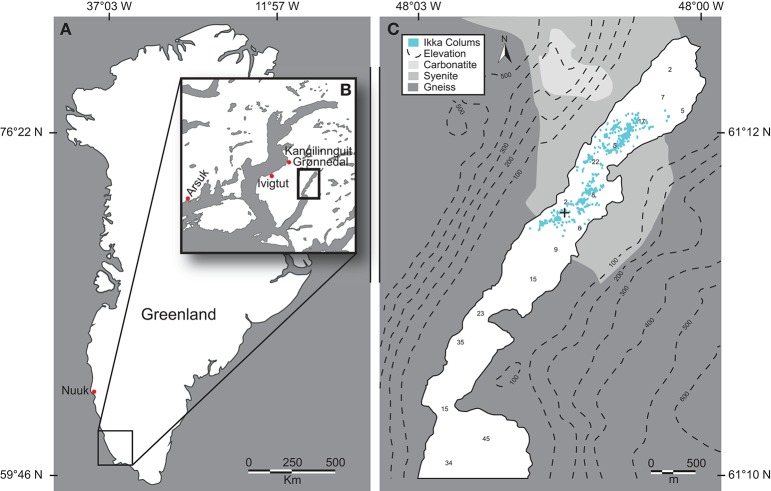
Ikka Fjord. (A) Map of Greenland with Ikka Fjord located in the SW. (B) Ikka Fjord and neighboring fjords. (C) Insert from (B), showing ikaite column distribution, and a coarse overview of the mineral contents of the surrounding mountain complexes, with topography displayed by isobars and distribution of ikaite tufas by blue dots (after Seaman and Buchardt, 2006). “+” denotes the location of the investigated tufa column.